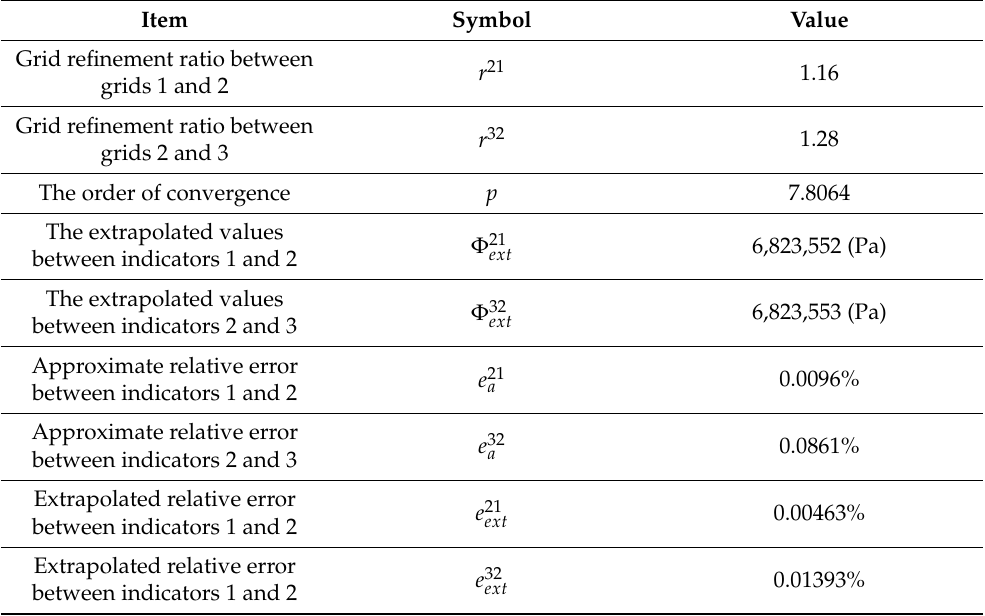
Figure 3. Meshes display of ( a ) the radial inlet, ( b ) the first stage impeller, and ( c ) the return channel. Usually, a gird independent study can give the proper mesh number of simulations, and we adopted the grid convergence index (GCI) method [38]. Three sets of grids were used in our verification, and their numbers were N 1 = 10 million, N 2 = 6.4 million, and N 3 = 3 million. The corresponding discharge total pressures were Φ 1 = 6,823,850 Pa, Φ Φ 2 = 6,824,503 Pa, 3 = 6,830,380 Pa, respectively. The results of the grid convergence study based on the GCI method are shown in Table 4. The GCI 21 and GCI 32 were less than 1%, indicating that the solutions were within the asymptotic range of convergence, and the exact solution was approximately obtained. Table 4. Grid convergence study using discharge total pressure as an